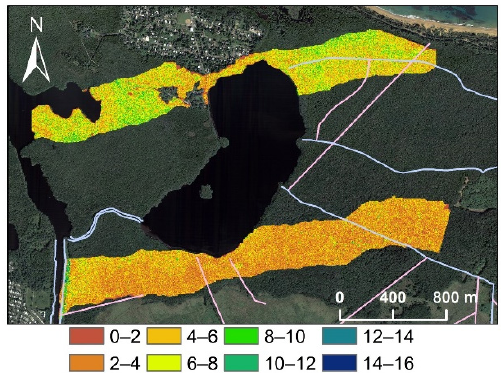
Figure 4. The intact tree density expressed as the number of trees in 5 m by 5 m grid cells. The numbers in the legend can be converted to number of trees per ha by multiplying 400.